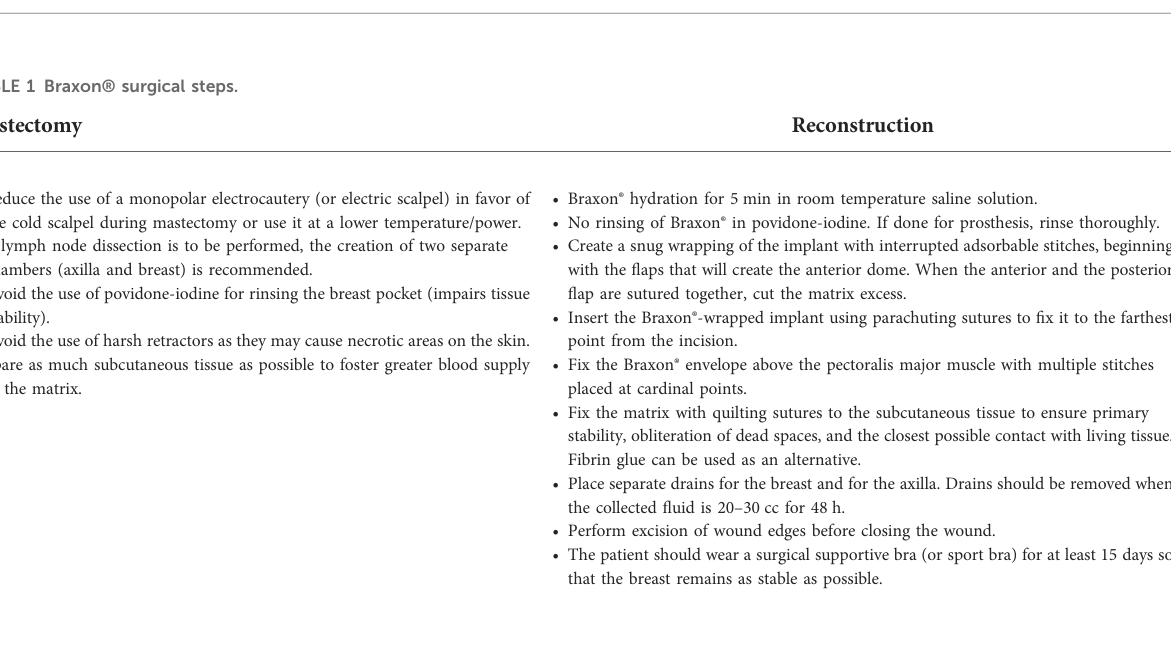
FIGURE 1 Schematic representation of a Braxon ® preshaped design and of the prepectoral technique. Figure adapted from Berna et al., 2014.